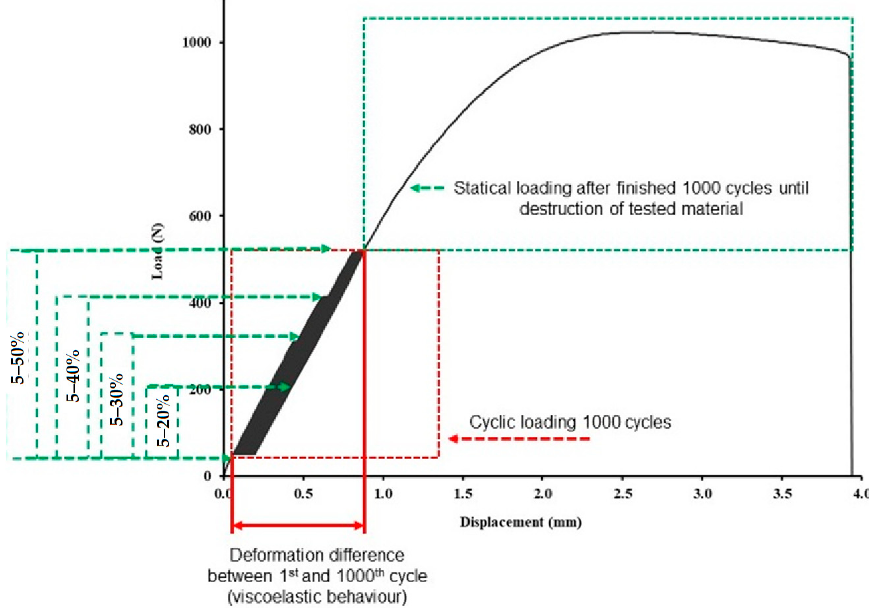
Figure 3. Low-cycle fatigue behaviour of 3D-printed PLA reinforced with natural bamboo reinforce-